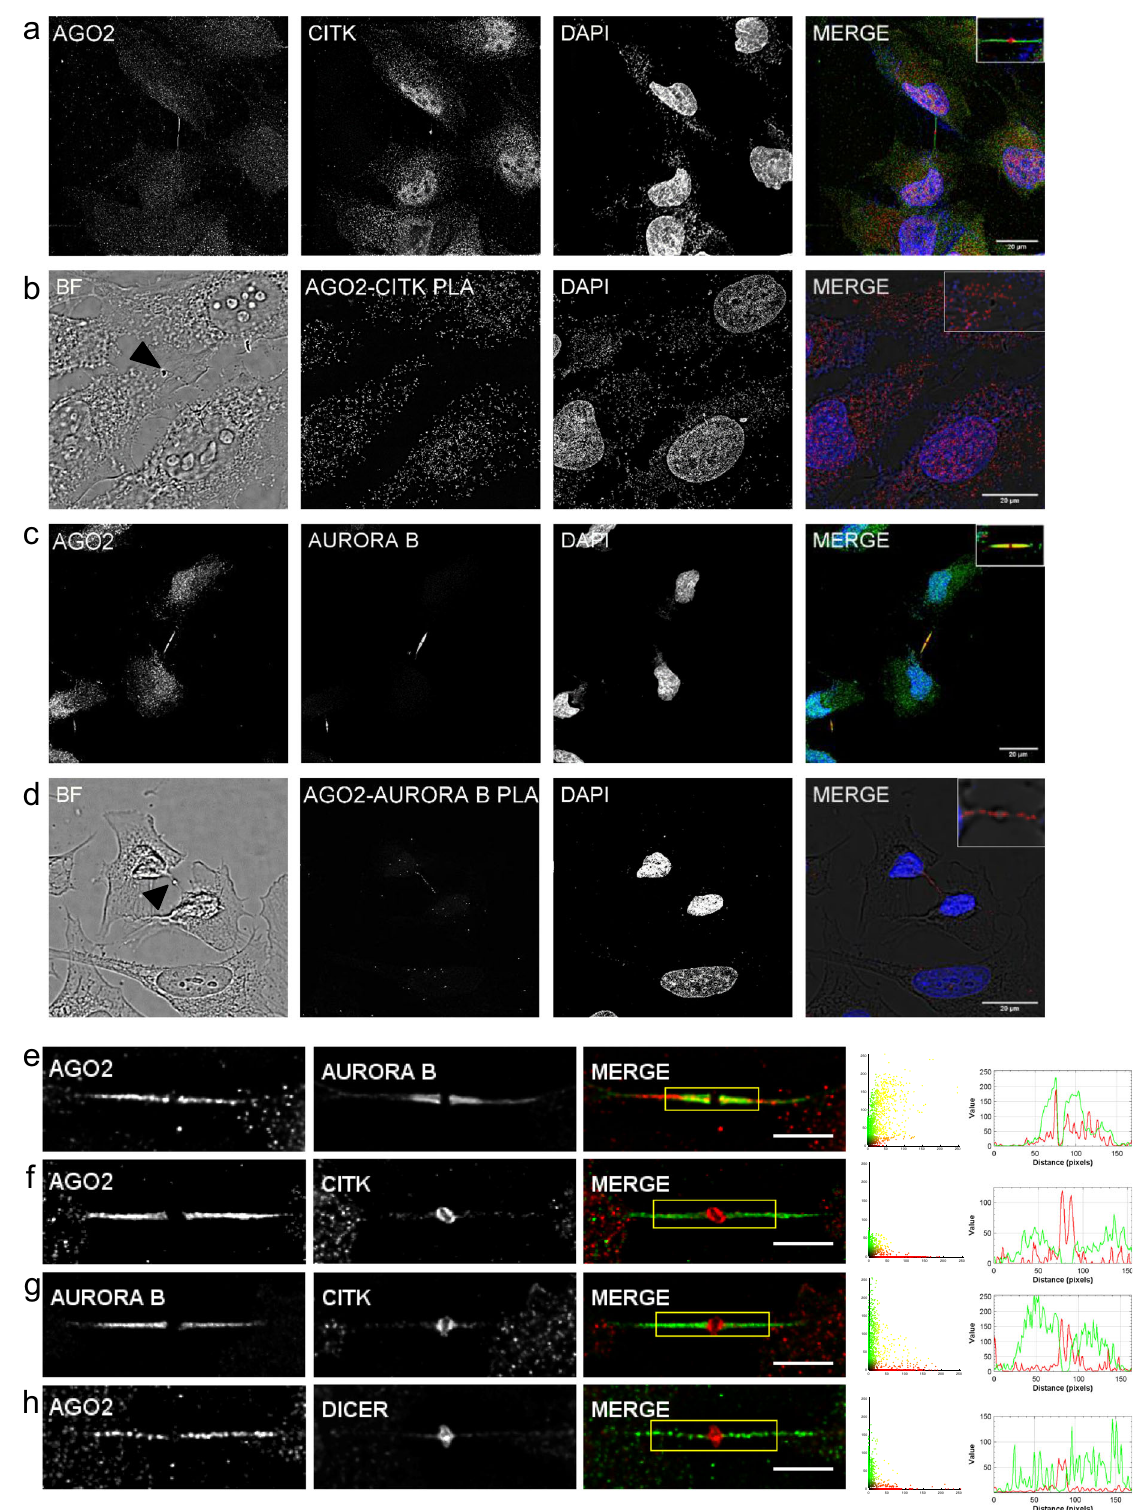
Fig. 3 AGO2 close-ended cellular structures are cytokinetic protrusions. Representative immuno fl uorescence images of NTHY ori 3-1 cells depicting the subcellular localization of AGO2 (green) with a Citron kinase (CITK) (red) and c Aurora B (red). Cell nuclei were stained blue (DAPI). b , d iPLA assays depicted the proximity of b AGO2 – CITK and d AGO2 – Aurora B as indicated by red foci. The black arrowheads in the Bright fi eld (BF) images indicate the midbody ring. The scale bar is 20 μ m. Visual assessment (merged images, scatterplots, and intensity lineplots) of colocalization between paired proteins included in the yellow region of interest of the merged images. f , h AGO2 (green) with CITK and Dicer (red), respectively. e , g Aurora B in green with AGO2 and CITK in red, respectively. Lineplots indicate the signal intensity of the paired proteins along the lines overlaid on the corresponding images that appear in Supplementary Fig. S4d – g. The colocalization metrics (Pearson [ R ] and Manders ’ [ M 1 and M 2] coef fi cients) and respective p values are presented in Supplementary Table S1 ( n = 6 biologically independent samples). Scale bar: 5 μ